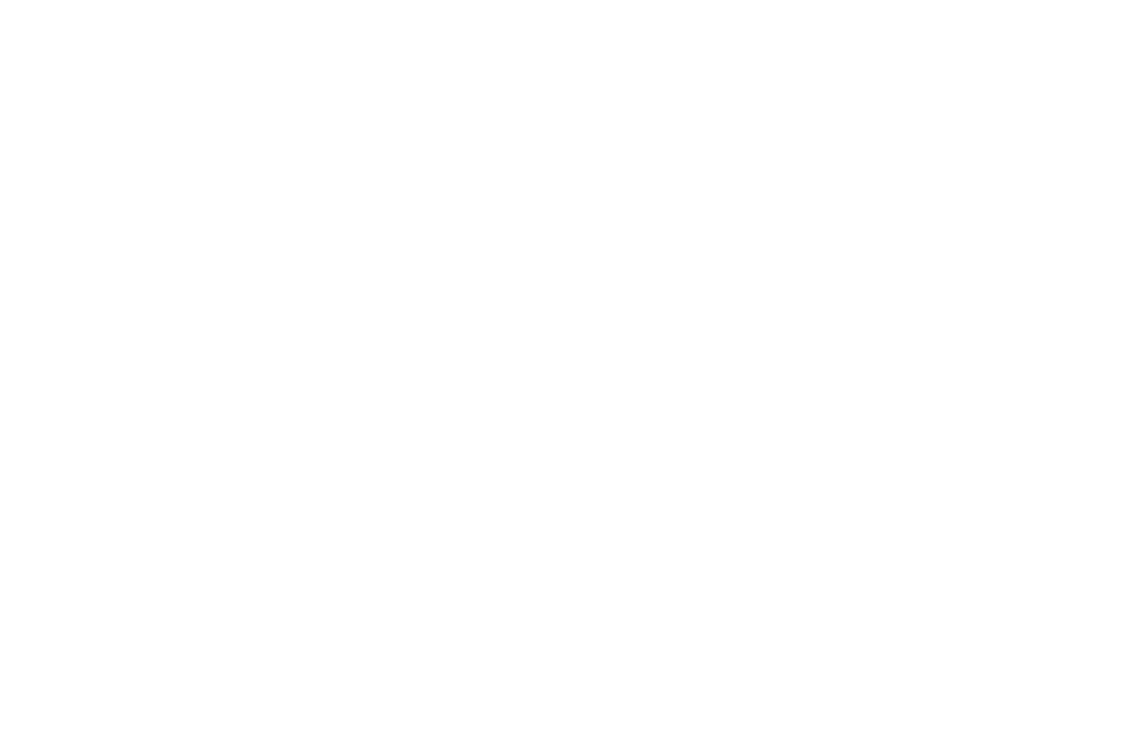
FIGUREA7 | Mean–averaged calculation error of compartmental abundances in dependence of the between-compartment separation and the metabolite error based on simulated data. The estimated maximum error is depicted as mean–average for each combination of between-compartment separation and metabolite error